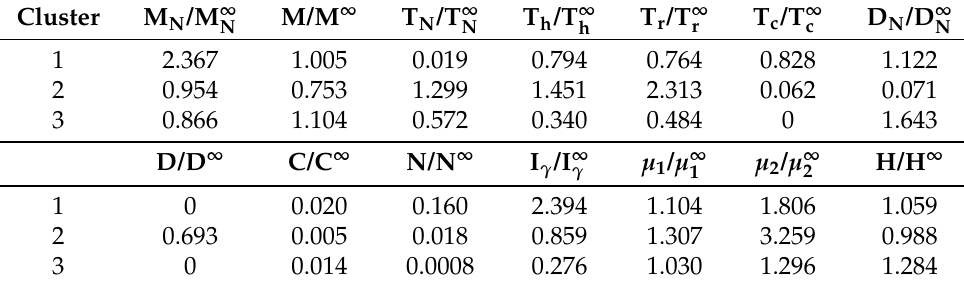
Table 3. The non-dimensional initial conditions for each